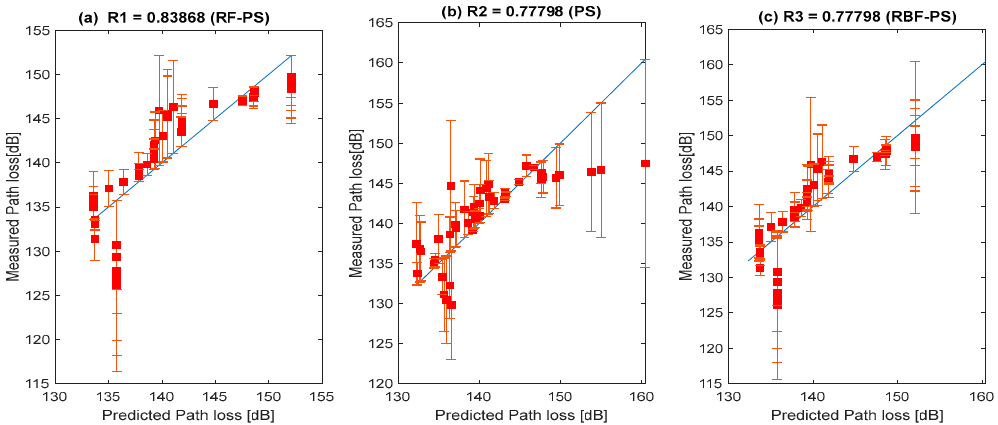
Figure 28. Results showing the correlation between the measured path loss and predicted path loss using the hybrid RF-PS prediction method and two existing standard path loss prediction methods in site 3 of location 3.